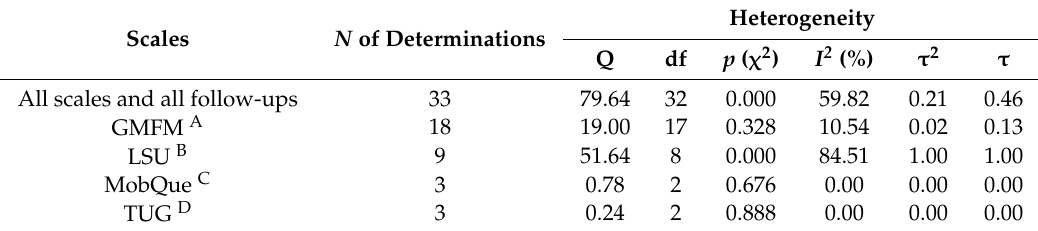
Table 4. Global heterogeneity in the intervention group: all scales and follow-ups. Scales N of Determinations